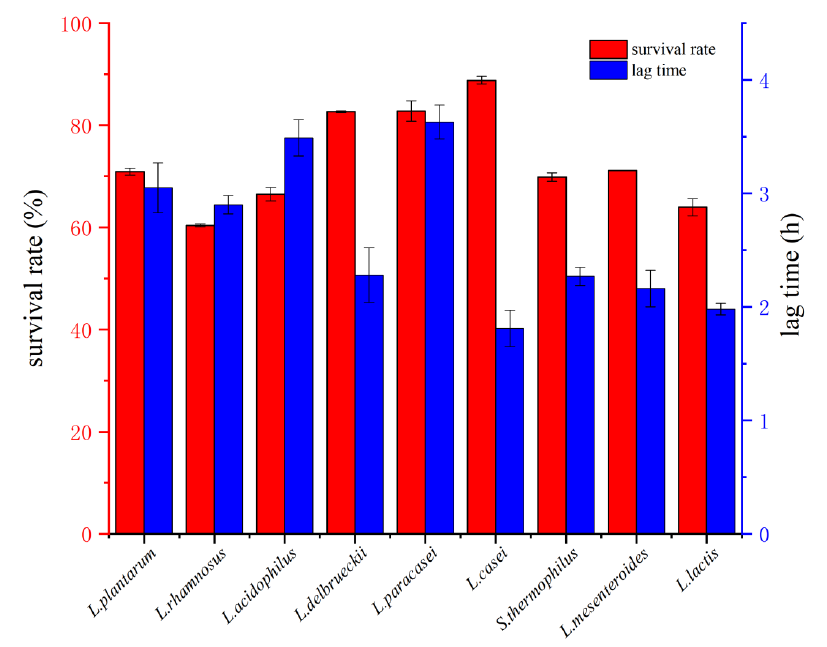
Figure 1. Tolerance to artificial gastric juice and bile salt of